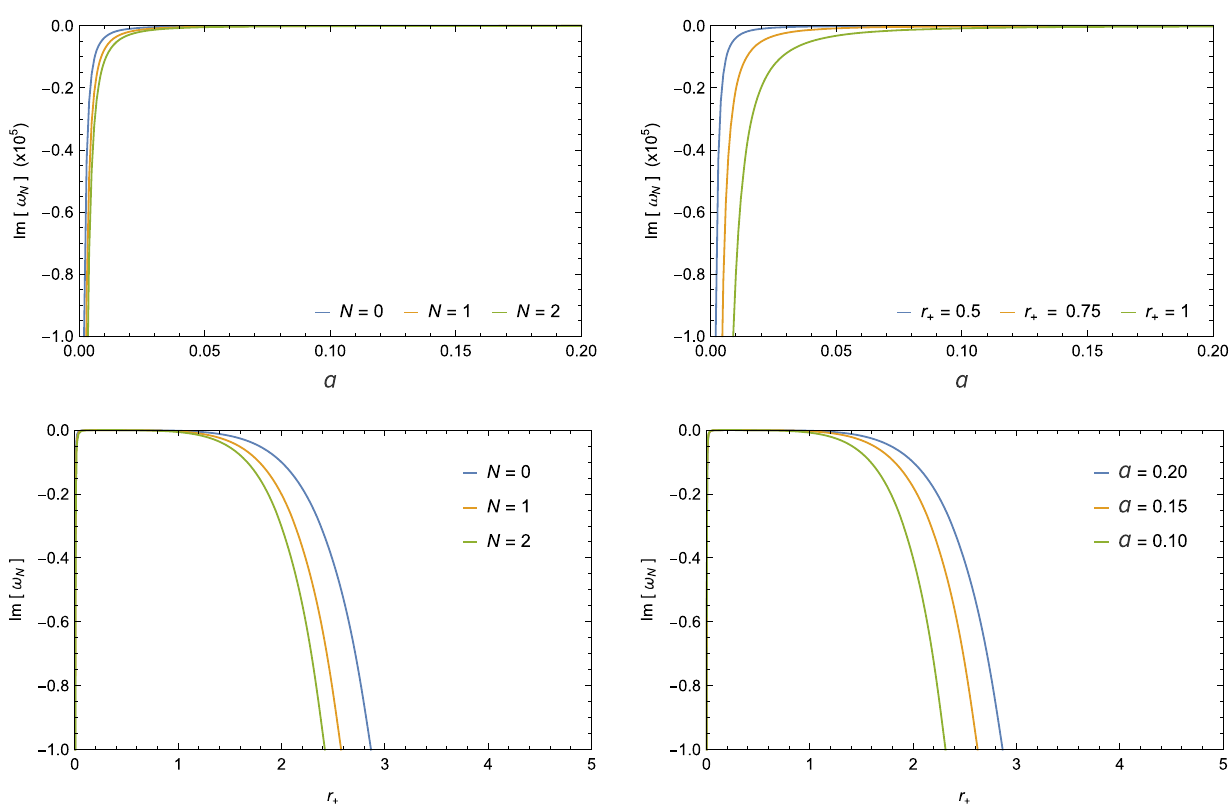
Fig. 12 (AdS) Case 2: a > 0. Top panel: Massless scalar QBSs as a function of the GB coupling constant for r + = 0 . 5 (left) and N = 0 (right). Bottom panel: Massless scalar QBSs as a function of the exterior black hole event horizon for a = 0 . 20 (left) and N = 0